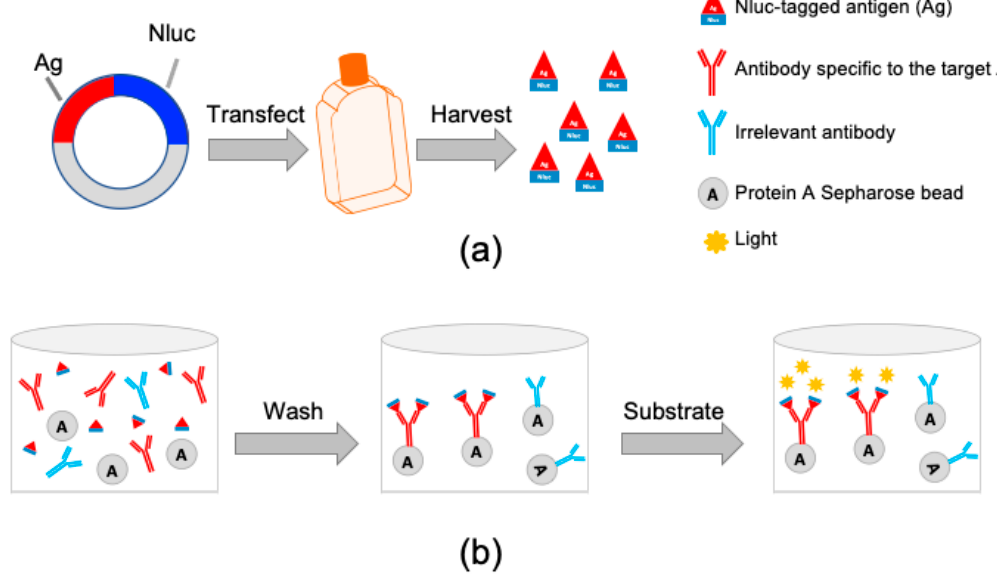
Figure 1. Schematic representation of the luciferase-immunoprecipitation system (LIPS). ( a ) Generation of luciferase-tagged antigens (Ag). Each individual PRRSV structural protein antigen is cloned in-frame to the 5 (cid:48) terminus of the nanoluc luciferase gene (Nluc). The resulting plasmid is transfected into HEK 293-T cells. At 60 h after transfection, cell lysate containing Nluc-tagged antigen is harvested and used for the LIPS. ( b ) Evaluation of immunoreactivities against the NLuc-tagged antigens. Cell lysate containing Nluc-tagged antigen is incubated with test serum samples together with protein A Sepharose beads in a filter 96-well plate. If the test samples contain antibody (IgG) specific to the Nluc-tagged antigen, the antigen-antibody complexes are formed, which are captured by the protein A Sepharose beads and retained in the well. Unbound NLuc-tagged antigen is washed away. Once the luciferase substrate is added to the well, the Nluc-tagged antigen bound to the bead will react with the substrate and produce luminescence. The light units produced by the Nluc-tagged antigen is proportional to the amount of antigen-specific antibody present in the test serum